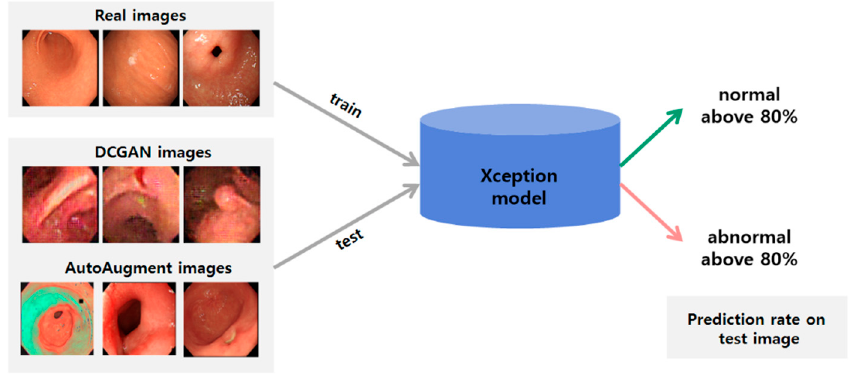
Figure 8. Process of the image quality measurement method.